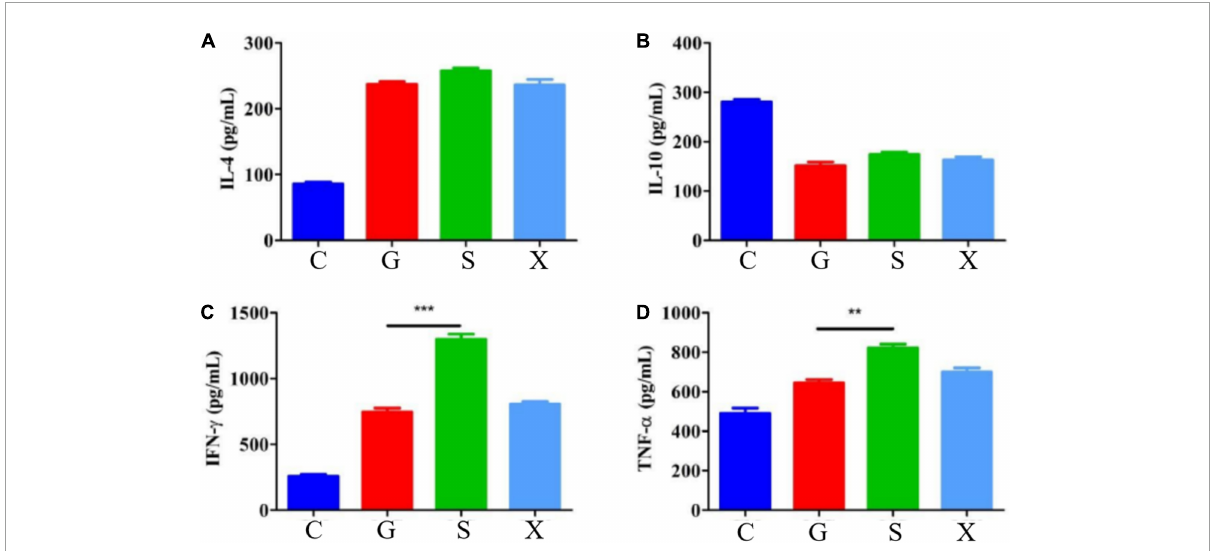
FIGURE4 Serum cytokines levels of IL-4, IL-10, IFN- γ , and TNF- α in mice with reactivation of Toxoplasma gondii . C: no T. gondii + DEX + PBS; G: 3 T. gondii cysts + DEX + PBS; S: 3 T. gondii cysts + DEX + koumiss; X: 3 T. gondii cysts + DEX + mare’s milk; (A–D) Indicate IL-4, IL-10, IFN- γ and TNF- α of serum cytokines levels, respectively. All data are expressed as mean ± SD. ** P < 0.01; *** P < 0.001.